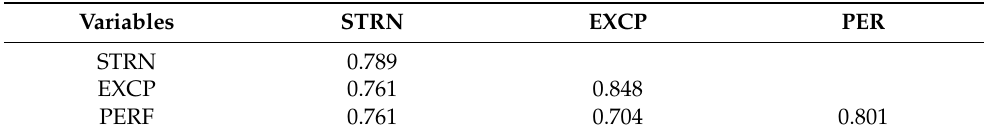
Table 4. Discriminant